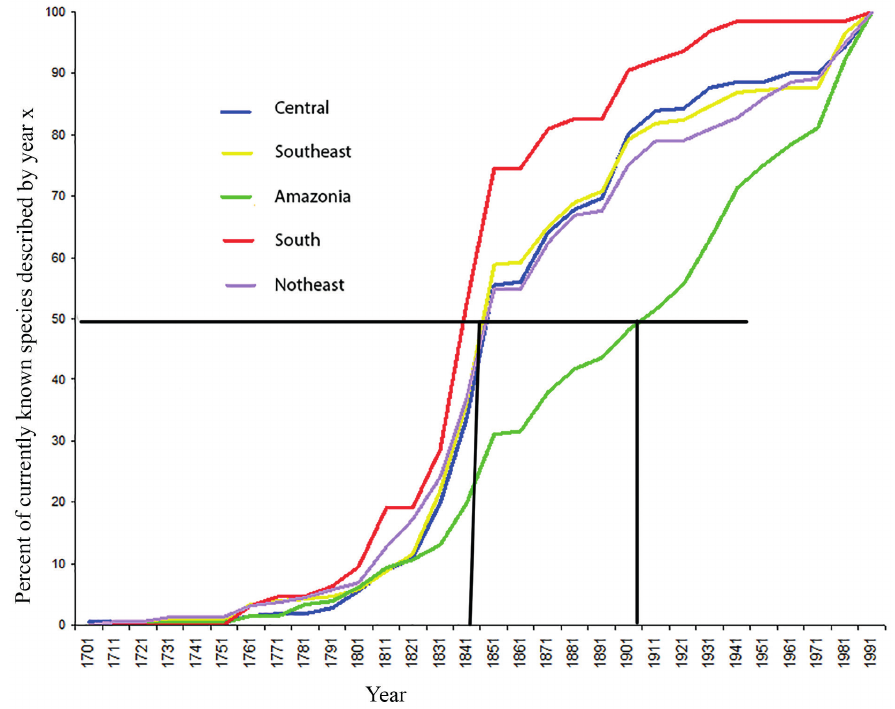
Figure 4 - Species discovery curves for Angiosperm species for 5 geografic regions of Brazil, indicating when the 50% of current knowledge point was reached.